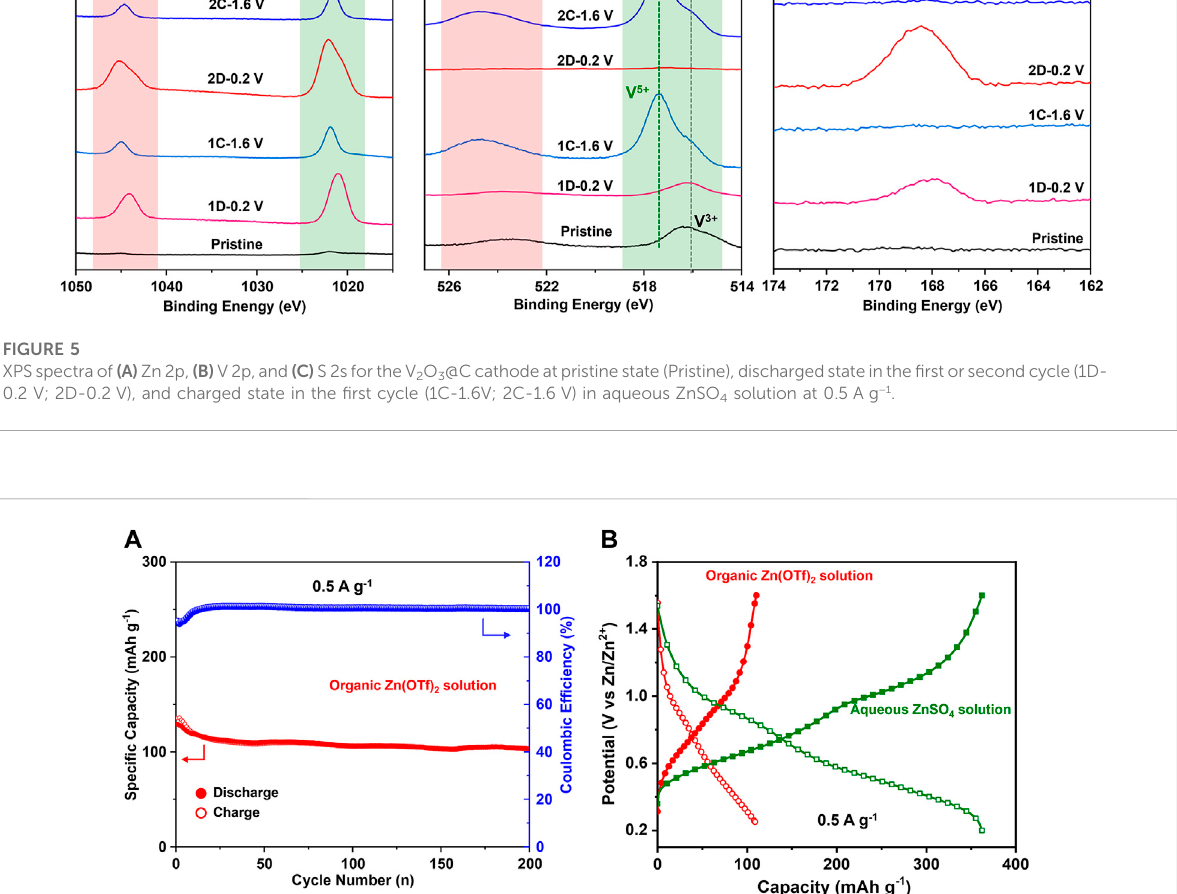
− 1 . (B) Discharge/charge curves in the 50th cycle for the